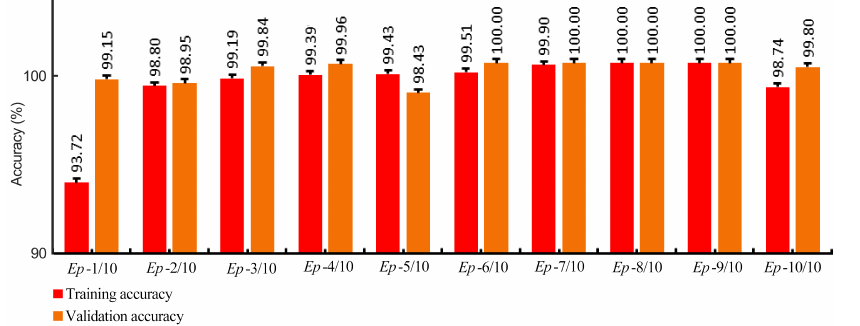
Fig. 6 Training and validation accuracy with respect to per epoch.